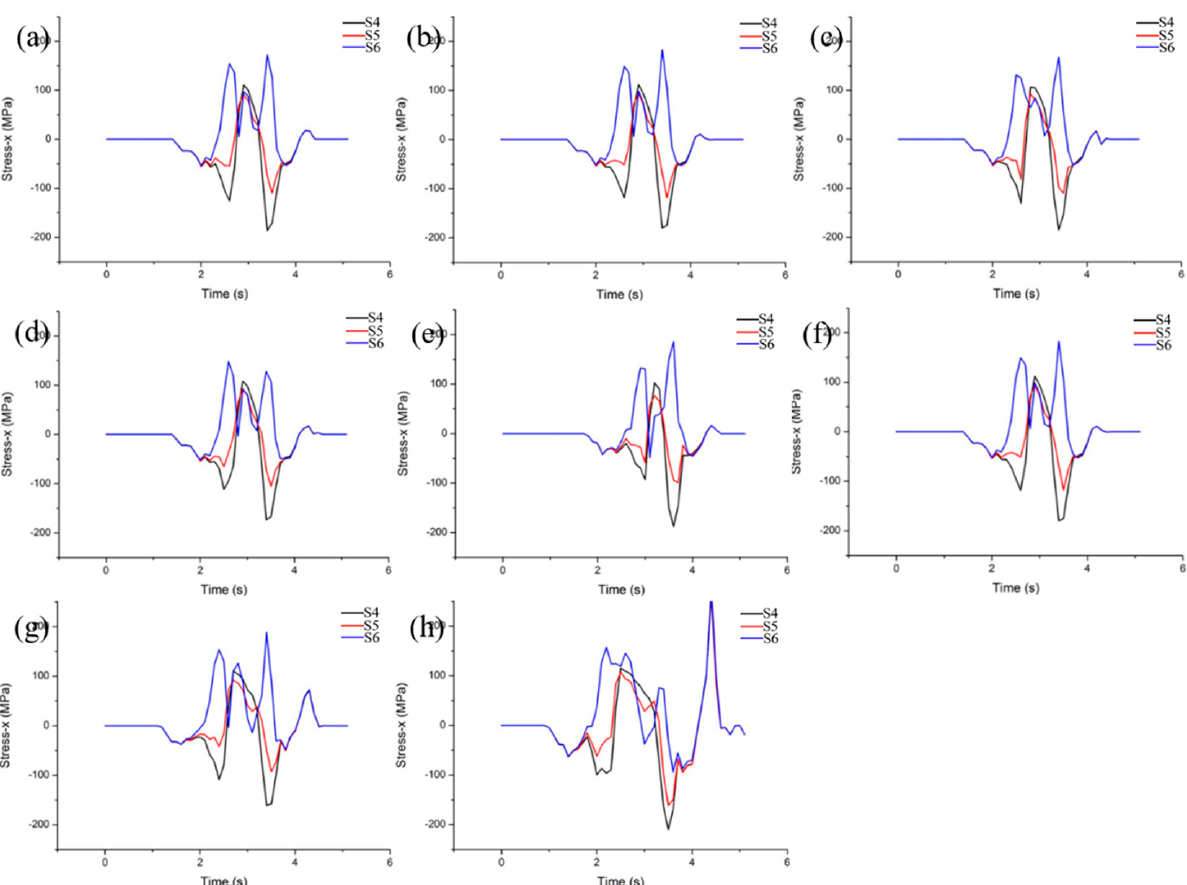
Figure 12. The additive tensile stress changes along TD on RD − ND plane at different temperatures ( a – d ) 1300–1600 °C, and different reductions ( e – h ) 10–40%.